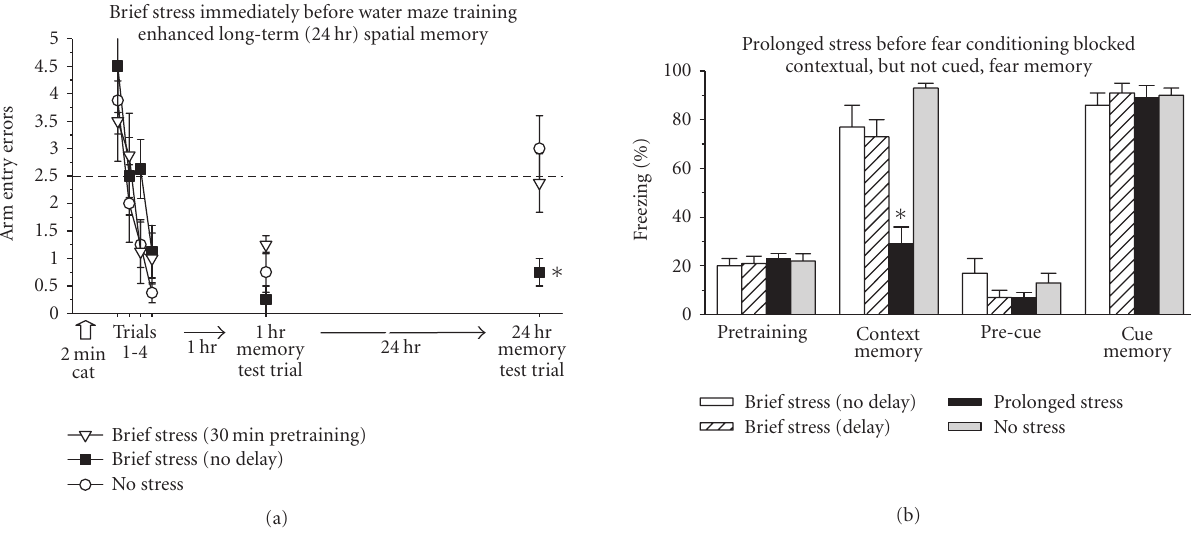
Figure 4: Brief stress immediately before training enhances, and prolonged stress impairs, hippocampus-dependent memory. (a) illustrates the influence of 2 minutes of predator exposure on spatial memory. Rats were exposed to a cat for 2 minutes and then they were given minimal radial arm water maze training (4 trials to find the hidden platform) either immediately or 30 minutes later. Rats trained under nonstress conditions or with cat exposure 30 minutes before training showed no evidence of memory for the platform location 24 hours later (open circle and open triangle). In contrast, rats trained immediately after brief exposure to a cat showed strong 24-hour memory (filled square). The dashed line at 2.5 errors indicates chance level of performance. (b) illustrates the e ff ects of brief versus prolonged water immersion on contextual and cued fear conditioning. Rats given brief water stress either immediately (open bar) or 8 minutes (diagonal lines) before fear conditioning exhibited intact contextual and cued fear memory which was equivalent to that found in the no-stress group (gray bar). Rats given repeated pretraining water immersions (solid bar), by contrast, exhibited intact cued fear memory, but had a complete absence of contextual fear memory. “Precue” indicates baseline freezing in the nonshock context (3-minute duration) prior to the delivery of the tone (3-minute duration). Prolonged pretraining stress, therefore, completely suppressed contextual (hippocampus-dependent) fear conditioning without having any e ff ect on cued (amygdala-dependent) fear conditioning. In both graphs, ∗ = P < . 05 (ANOVA and Holm- Sidak post-hoc test) compared to the no-stress